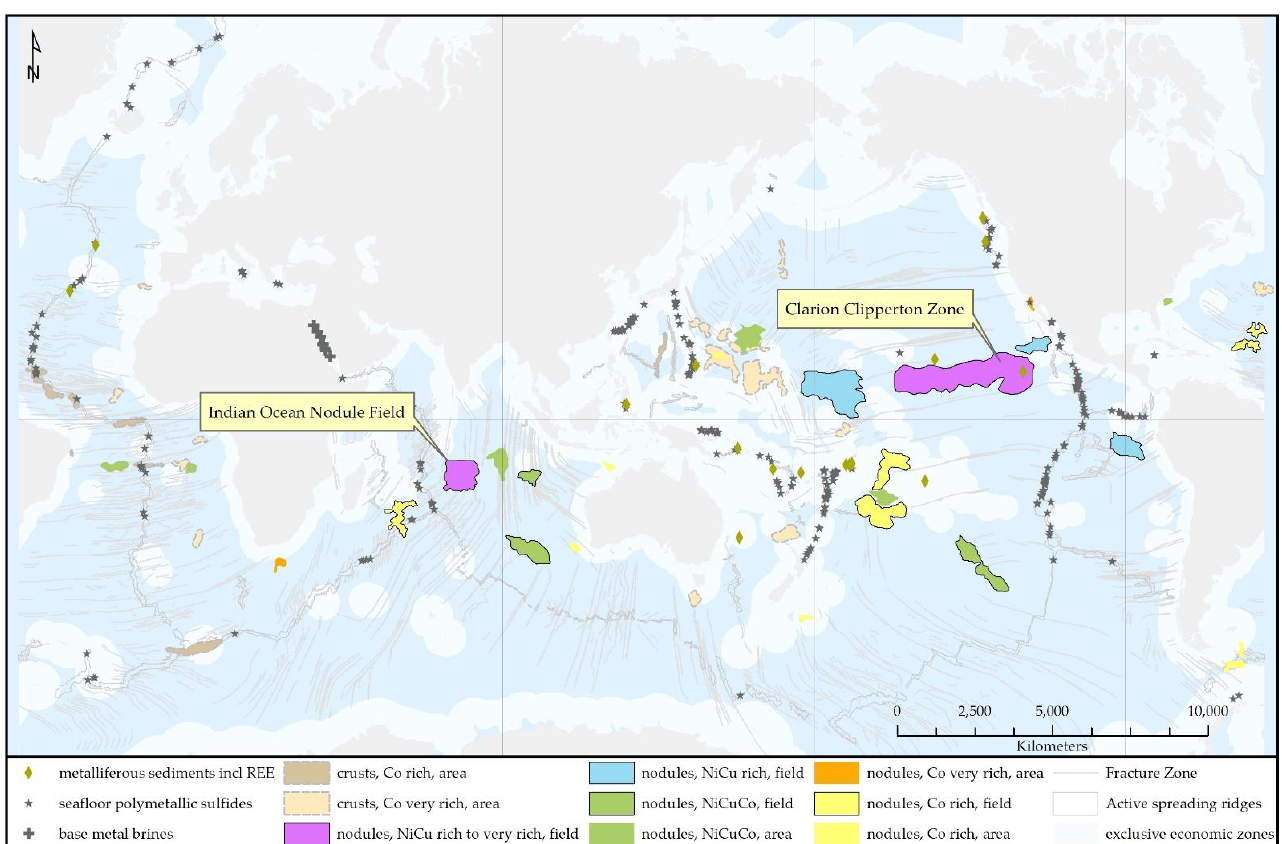
Figure 1. Locations of the Clarion Clipperton Zone and Indian Ocean Nodule Field. Adapted from Andreev et al. [6] and Matthews et al. [7]. Rich Co is generally >0.4%, very rich Co is >0.8%, NiCuCo is 0.7 – 1.7% Ni + Cu, rich Ni-Cu is >1.7% Ni + Cu, and very rich Ni-Cu is >2.5% Ni + Cu; the fields are better constrained from sampling than the areas.